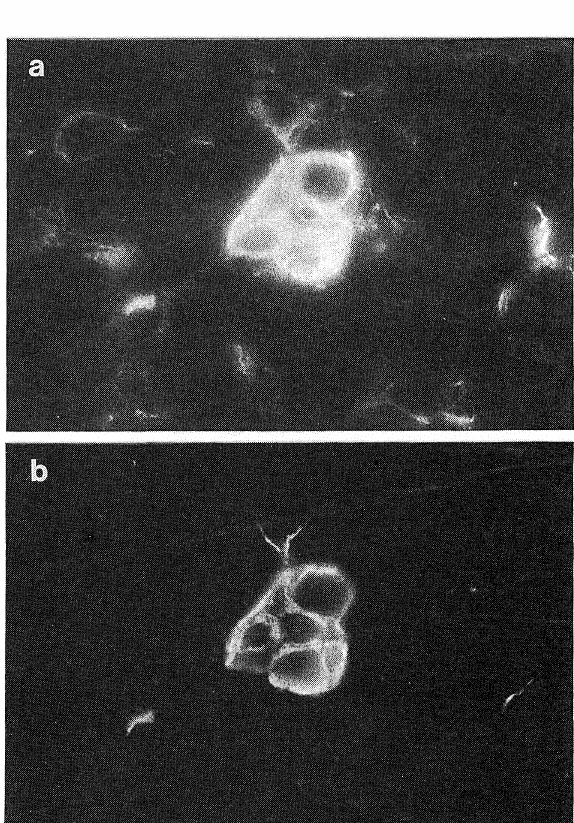
FIGURE 5. Photomicrographs of a section from the thymus of a 17-day-old murine fetus, showing double-labeled cells. (a) Labeling with ER-TR5 + RARA-FITC. (b) Labeling with biotiny- lated ER-TR4 + avidin-Texas red x